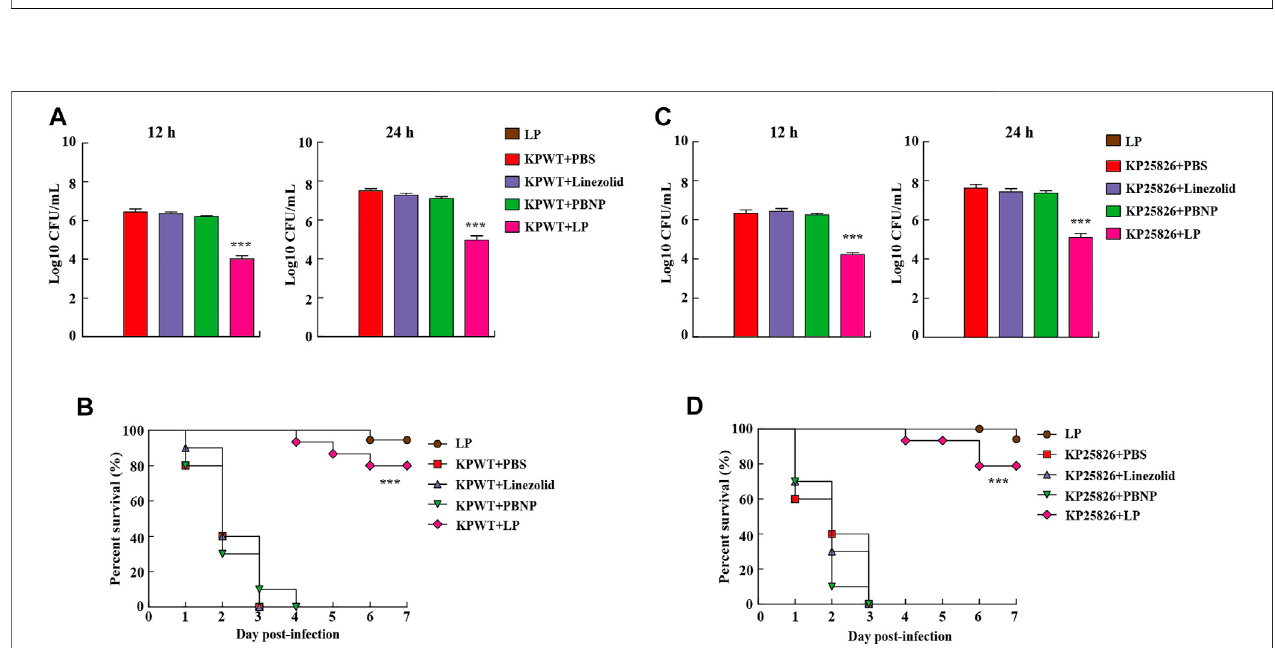
FIGURE5| ResidualCFUs andsurvivalrateof C.elegans infected with K.pneumoniae .The C.elegans wereinfected atday 0withKPWTor KP25826andtreated withPBS,linezolid(16 μ g/ml),PBNP(8 μ g/ml)orLPfordeterminingbacterialburdensatposttreatment12and24 h (A,C) .Thesurvivalrateof C.elegans wasmonitored for the subsequent 7 days (B,D) . PBS was used as a control. *** p < 0.001.